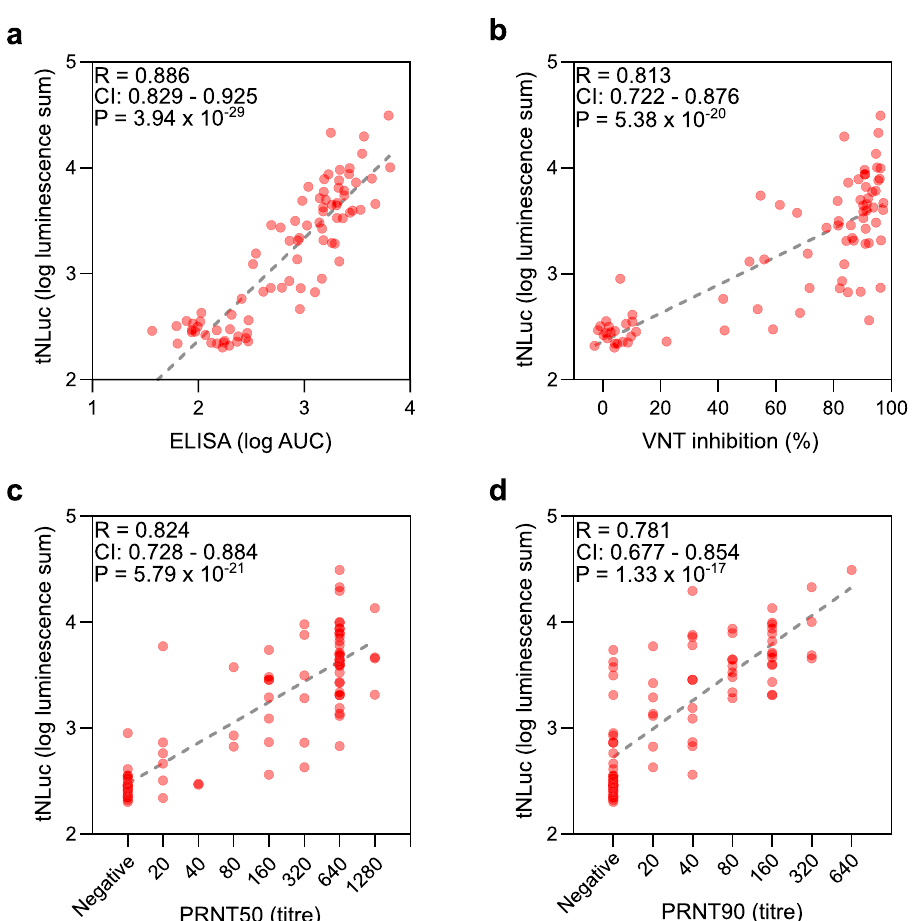
Fig. 4 Comparison of SATiN assay with ELISA and neutralizing antibody assays. a The 84 serum samples described in Fig. 3 were tested using ELISA and the results are compared with SATiN using a scatter plot. b – d Eighty sera were subjected to neutralizing antibody tests: sVNT ( b ), PRNT50 ( c ), and PRNT90 ( d ). R and P -values were obtained from two-tailed Pearson correlation analysis. Source data are available in the Source Data fi